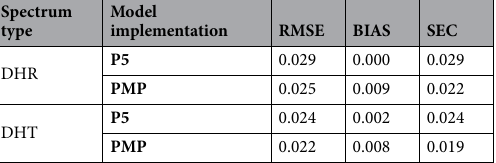
Table 2. Global performance evaluation of simulated leaf spectra from P5 and PMP (n = 32).